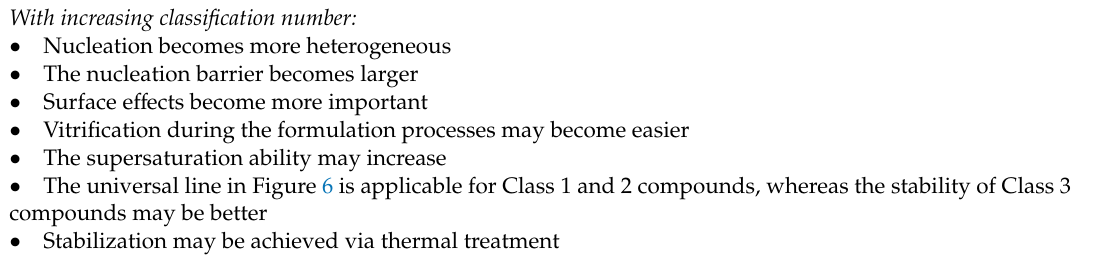
Table 6. Relevance of crystallization tendency classification for glass